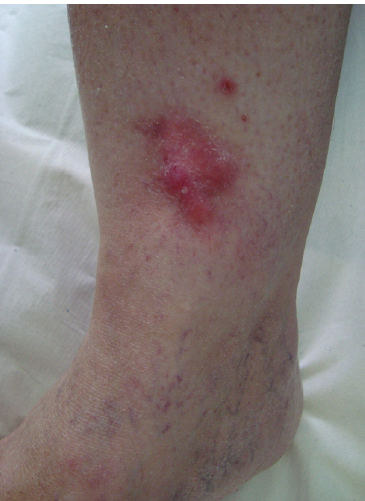
Figure 1: Clinical appearance of desmoplastic melanoma (patient n ◦ 4): red plaque of 5 × 3cm on left leg. The diagnoses that are suspected clinically range from basal cell carcinoma to dermatofi- brosarcoma protuberans or amelanotic